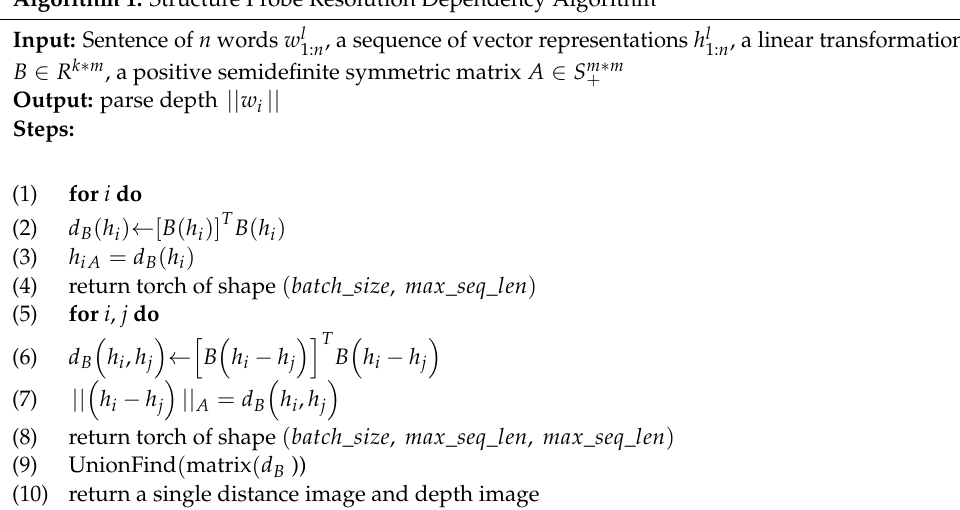
Algorithm 1: Structure Probe Resolution Dependency Algorithm